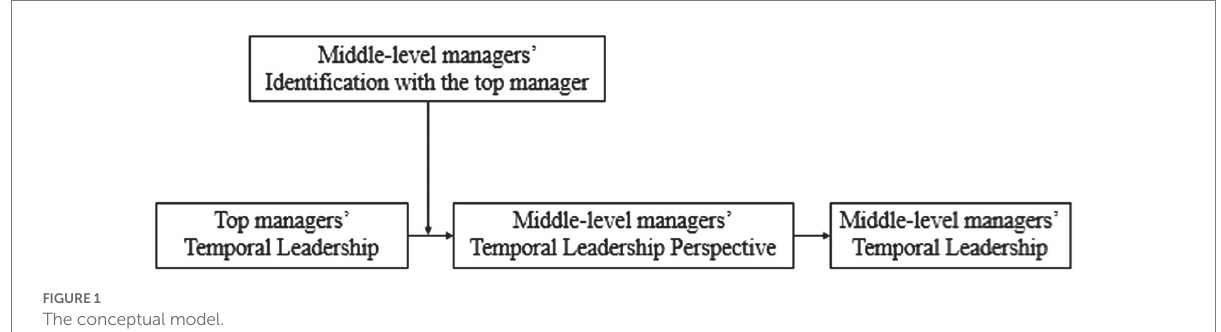
TABLE 3 Results of hierarchical regression analysis.